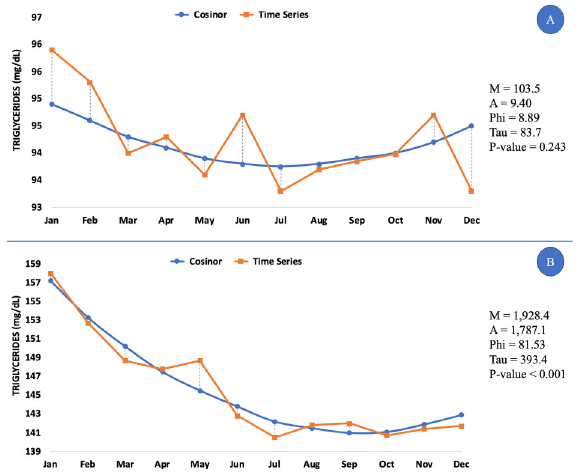
Figure 3. Cosinor analysis for triglycerides in normolipidemic ( A ) and dyslipidemic ( B ) individuals during the eight-year study period. Measured parameters: M: MESOR (as mg/dL); A: amplitude (as mg/dL); PHI: acrophase (as months of the year from January to December); TAU: period of rhythm (as months of the year); P-value: probability of biorhythms; n=15,651 cases of